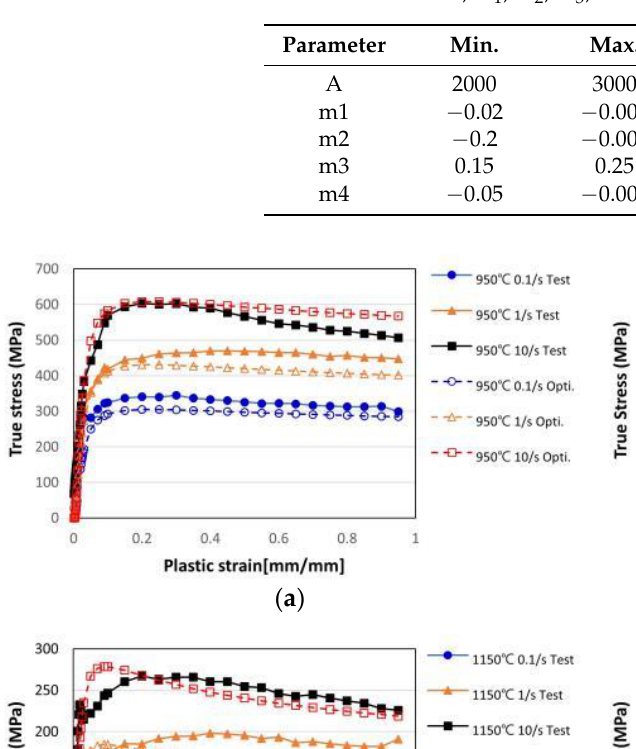
Table 1. Values of A, m 1 , m 2 , m 3 , and m 4 parameters after optimization.